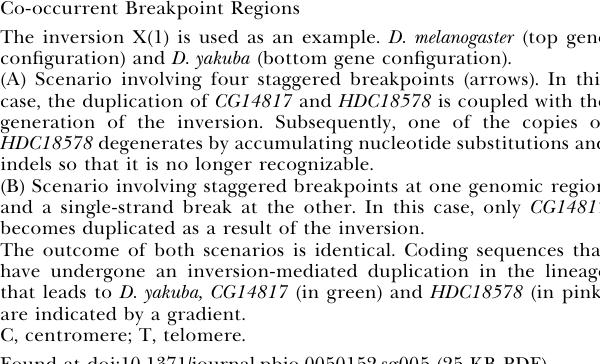
Figure S2. The Isochromatid Model with Staggered Single-Strand Breaks in the Case of the Inversion 3R(7) (A) Relative to the gene order of D. simulans, the region from CG15179 to CG17603 is inverted, due to a prior event (dotted line). (B and C) Inversion 3R(7) originates from two pairs of staggered single-strand breaks (short horizontal solid lines), proximally on either side of CG31286, and distally on either side of CG34034. The